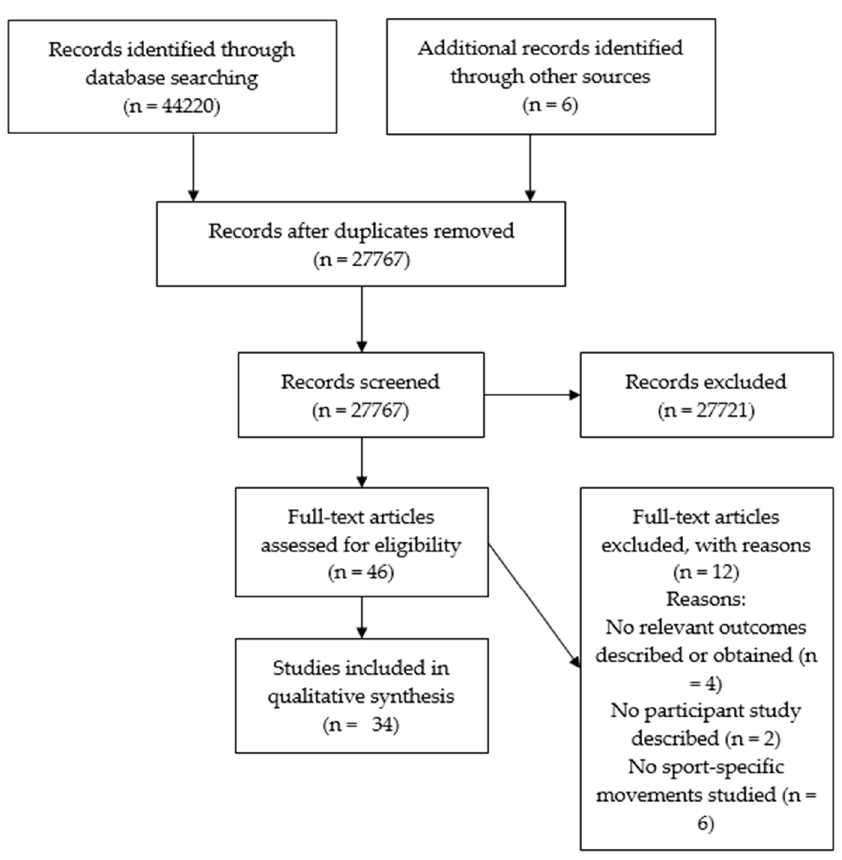
Figure 1. PRISMA chart detailing the article selection process [57] .